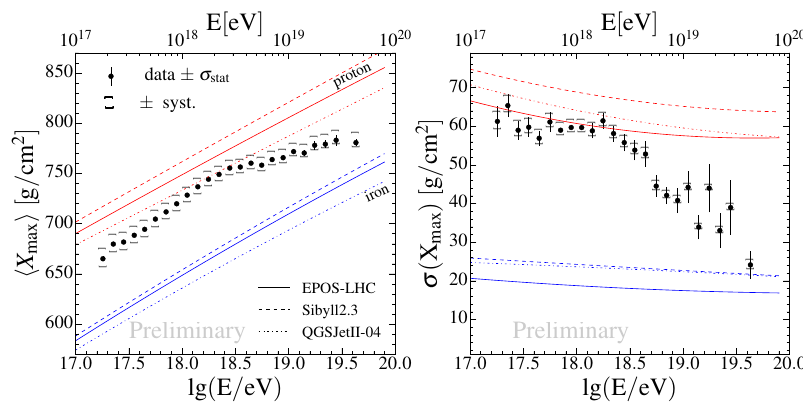
Figure 1. Evolution of the average value of X max with the energy (left) and its standard deviation (right) for both data and simulations